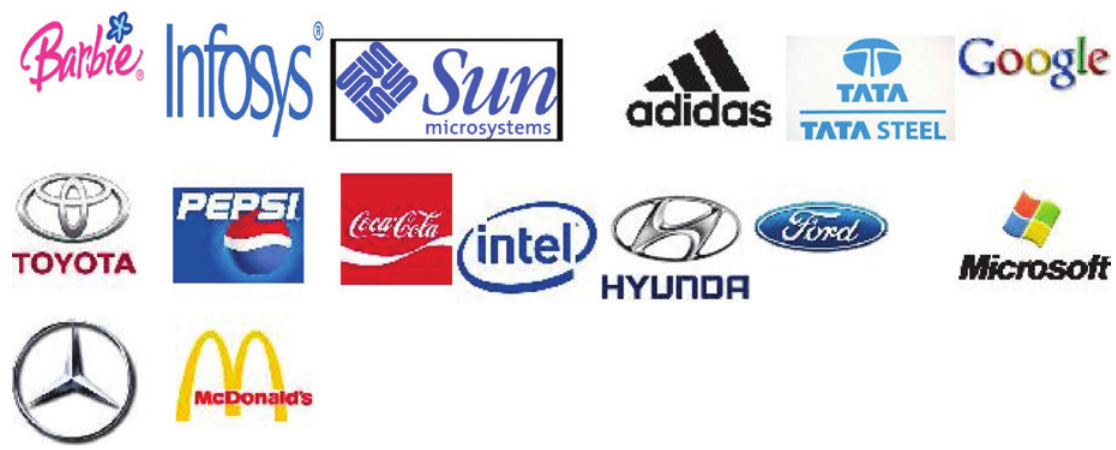
Figure 1: Sample Trademark Images from FlickrLogos-32 PLUS